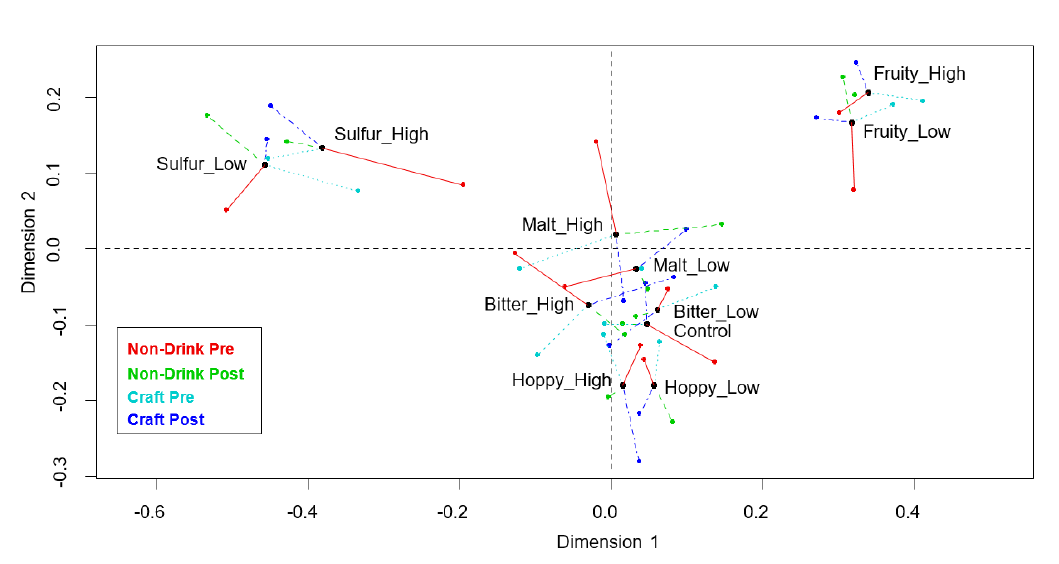
Figure 4. GPA plot for sensory profiling data pre and post training sessions, for both the craft-style panel (pre is light blue and post is dark blue) and non-drinkers panel (pre is red and post is green).